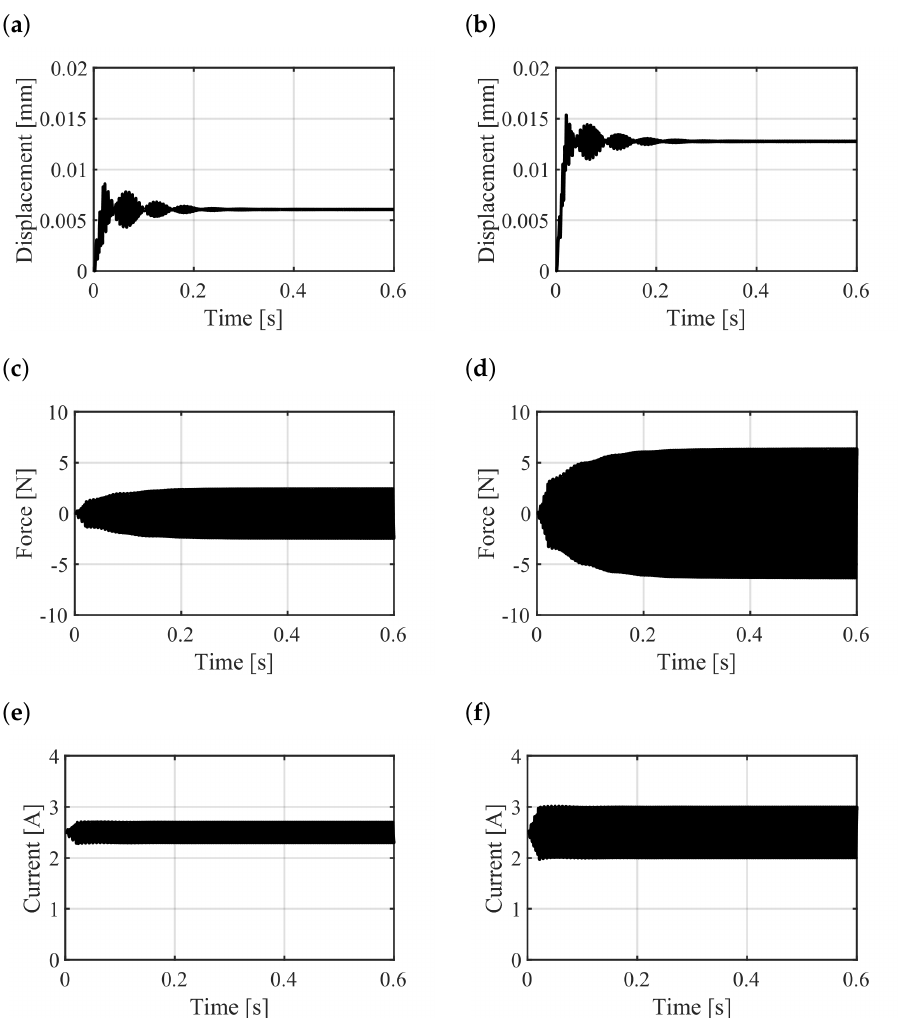
Figure 14. Responses to the unbalance: maximum displacement at the location of the AMB A ( a ) and the AMB B ( b ); force provided by the AMB A ( c ) and the AMB B ( d ); current supplied to the electromagnets of the AMB A ( e ) and the AMB B ( f